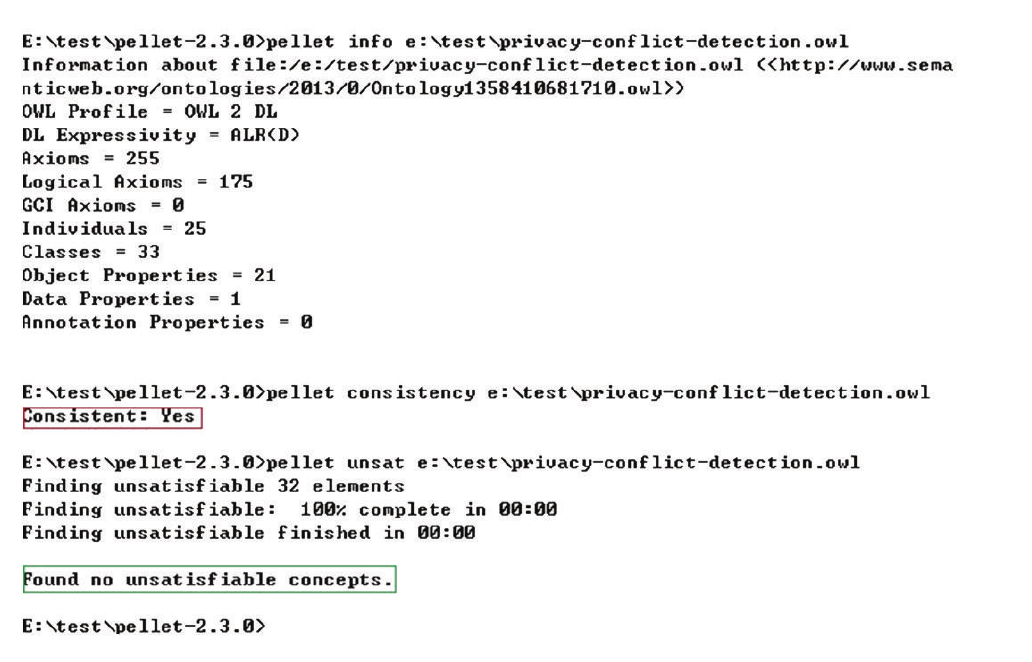
Figure 5: Checking results in privacy conflict detection